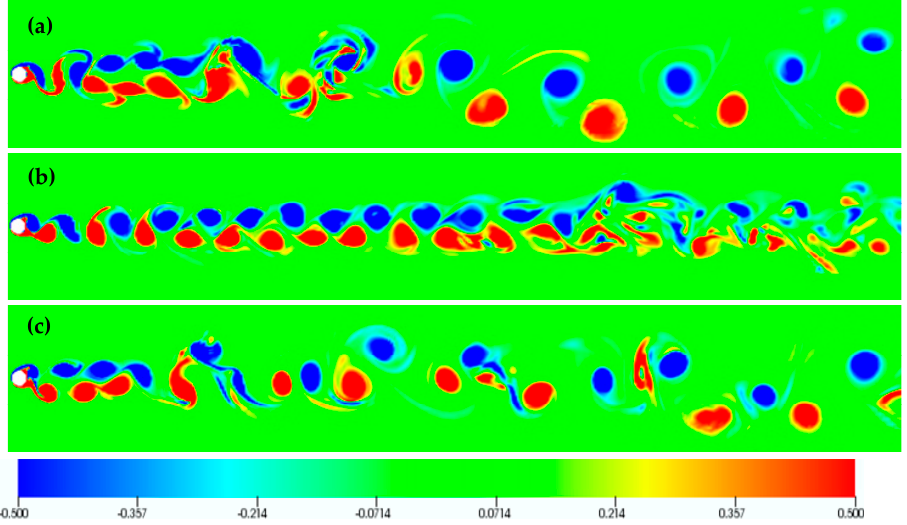
Figure 17. Counter-clockwise cylinder oscillation: Instantaneous isocontours of spanwise vorticity for the plane z = 3 for F = 1.1 and ( a ) A y /D = 0.20, ( b ), A y /D = 0.30, ( c ) A y /D = 0.40.